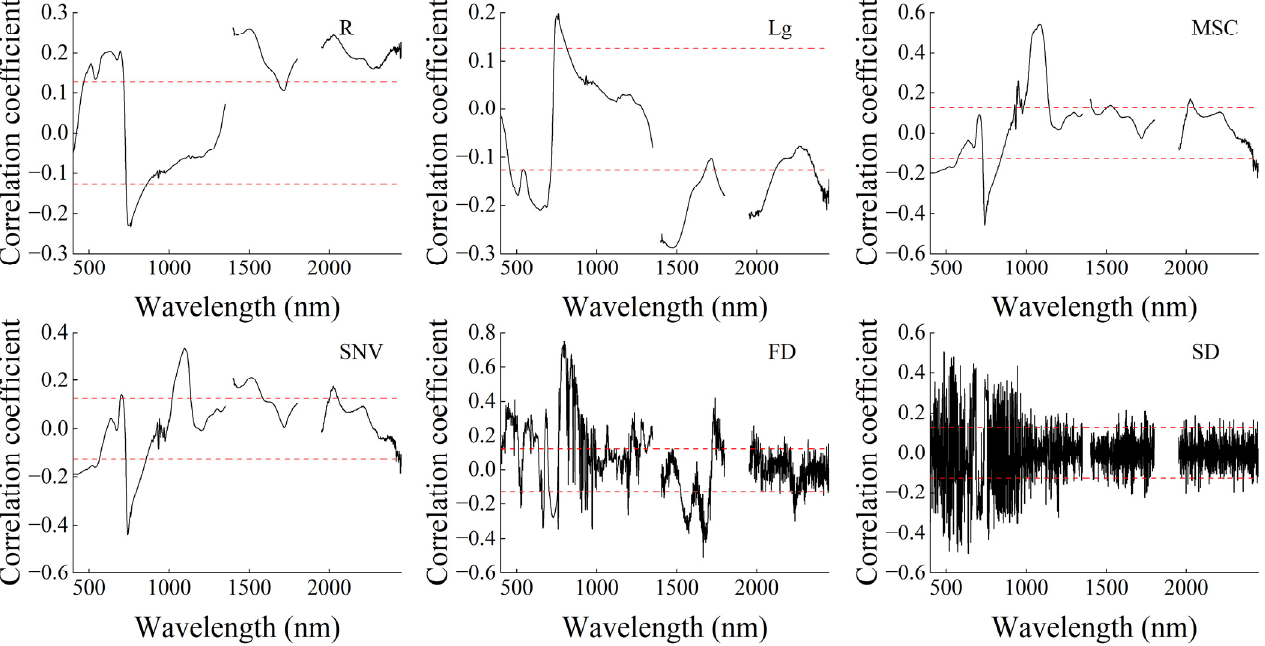
Figure 4. Correlation between R and preprocessing spectra and AGDB. Note: The red line is the critical value of signi fi cance ( p < 0.05).